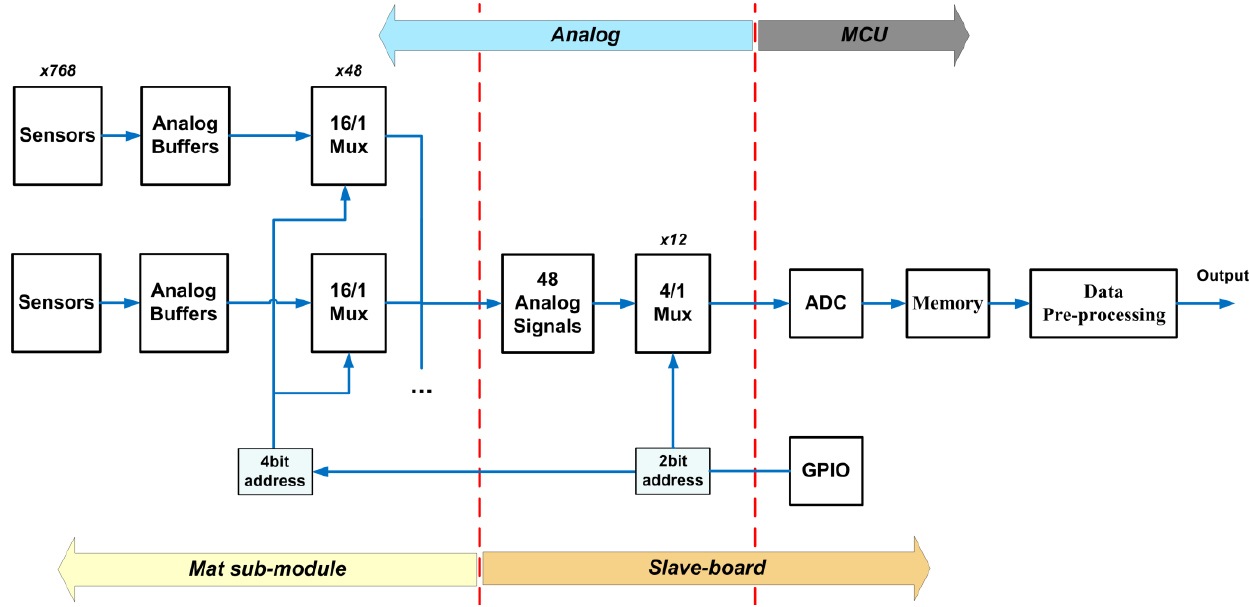
Figure 5. Overview of sub-module multiplexing architecture and data